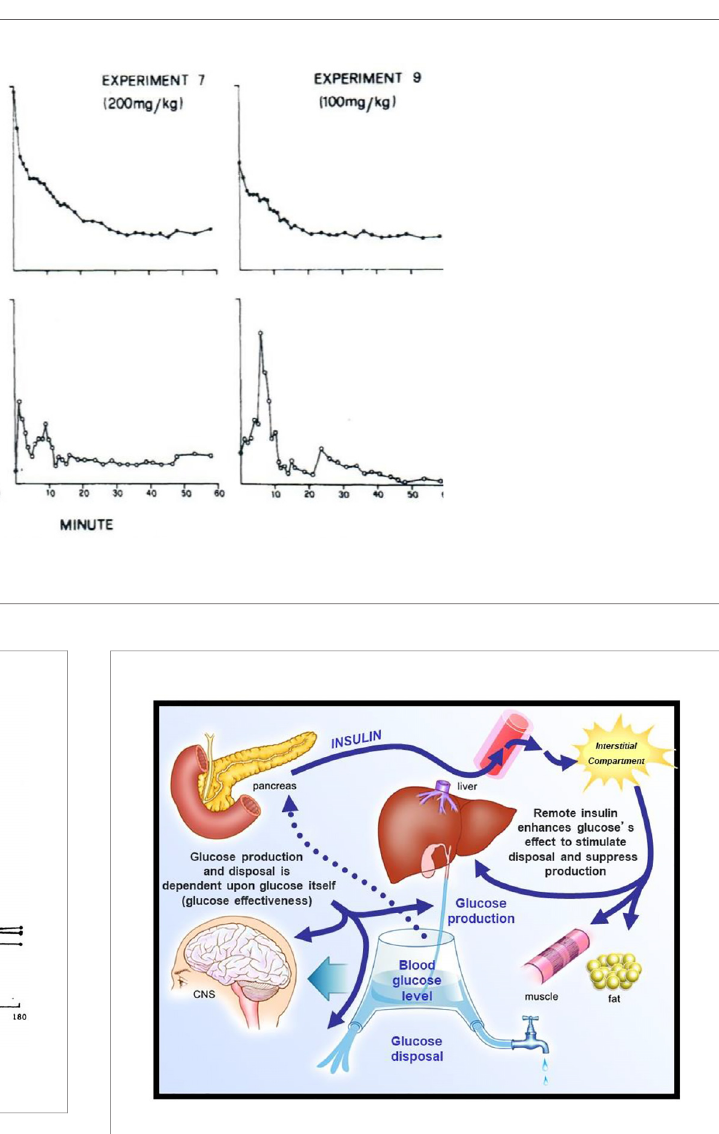
FIGURE 6 | Closed loop system of glucose